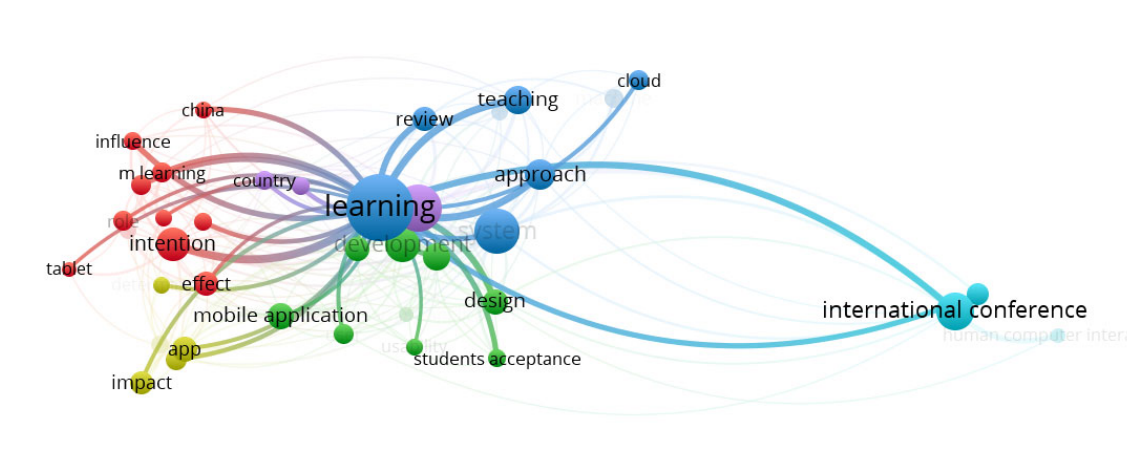
Fig. 1. Most used author keywords in mobile learning